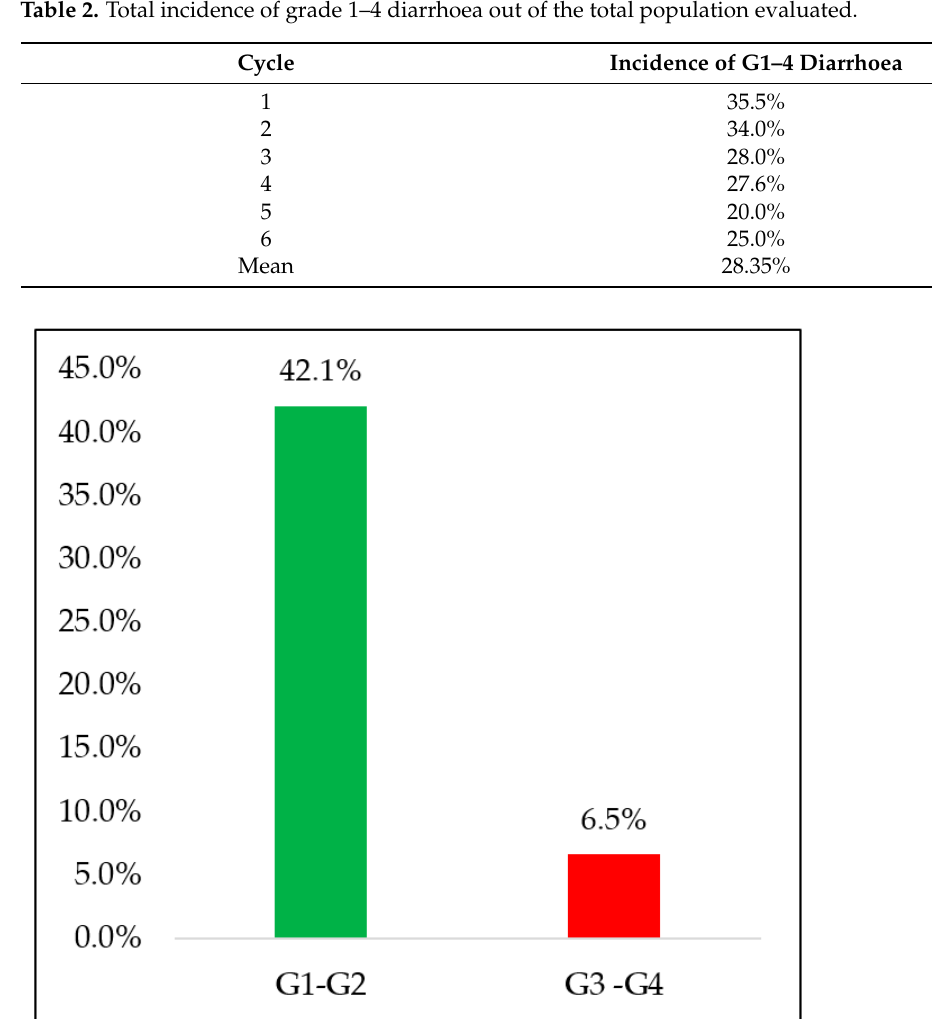
Figure 1. Percentage of patients with severe (G3–4) or mild (G1–2)